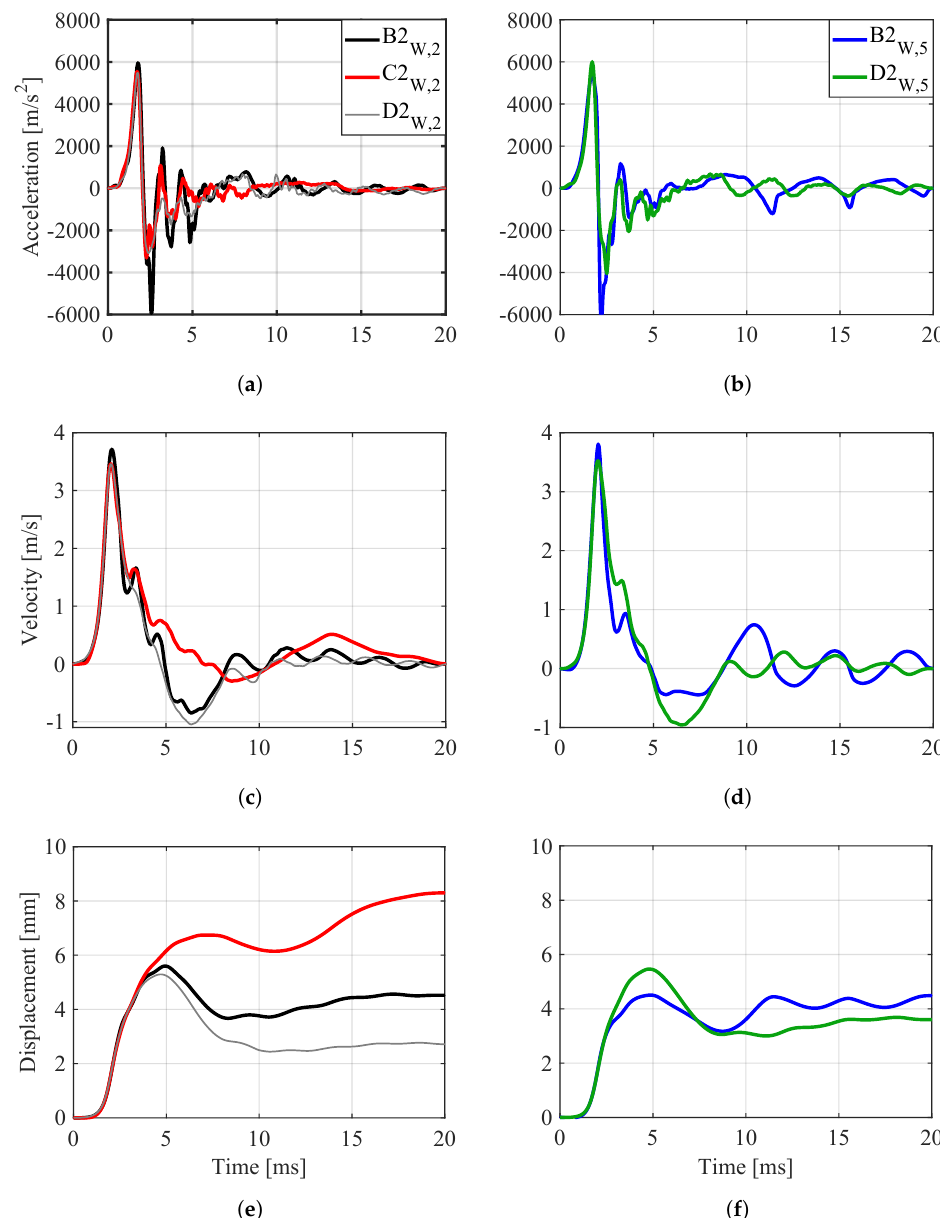
Figure 13. ( a ) Acceleration at the west accelerometer for Beams B2–D2 during the second impact test; ( b ) acceleration for B2 and D2 during the fifth impact test; ( c ) integrated velocity for B2–D2; ( d ) integrated velocity for B2 and D2; ( e ) integrated displacement for B2–D2; and ( f ) integrated displacement for B2 and